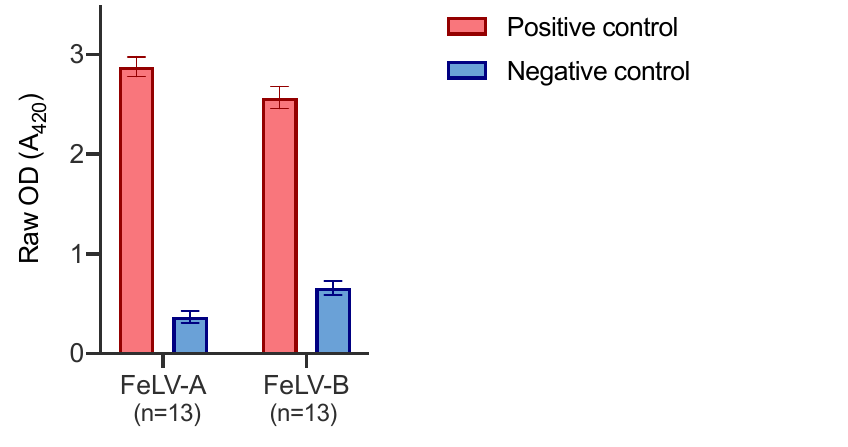
Figure 5. Inter-assay variation of FeLV-A and FeLV-B SU ELISA. The positive control comprised plasma collected and pooled from experimentally infected cats known to have a high VNA titre against FeLV-A. The negative control comprised pooled plasma samples that showed low reactivity to FeLV-A by immunoblot. Error bars represent standard deviation values which were ≤ 0.11 in all cases.